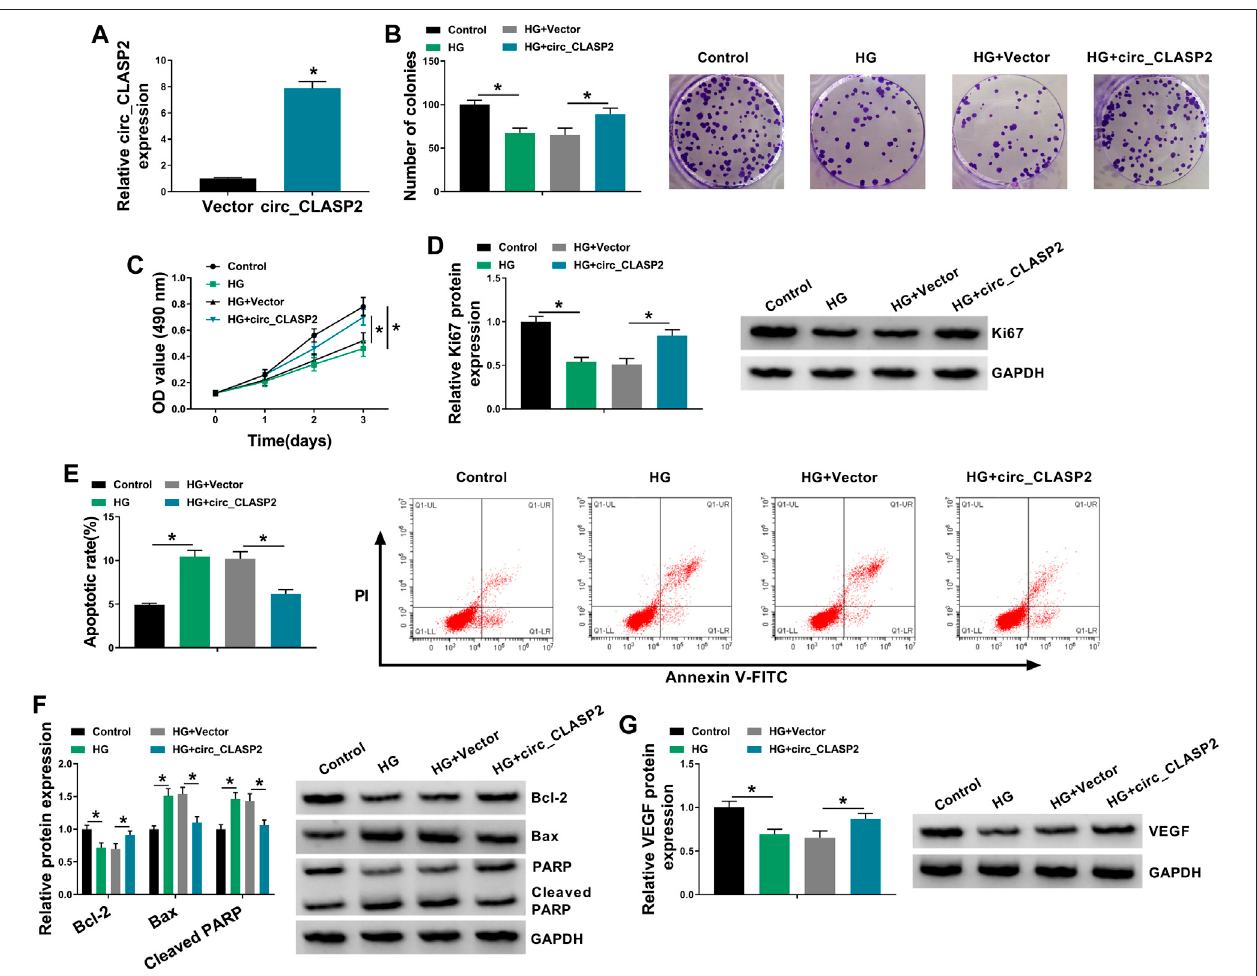
FIGURE 2 | Circ_CLASP2 overexpression promoted proliferation and inhibited apoptosis in HUVECs under HG conditions. (A) Circ_CLASP2 expression was assessed by qRT-PCR in HUVECs transfected with Vector or circ_CLASP2. HUVECs were transfected with Vector or circ_CLASP2 and then treated with HG, followed bythemeasurementofcellcolonyformationusingacolonyformationassay (B) ,cellproliferationbyMTTassay (C) ,Ki67levelbyWestern blot (D) ,cellapoptosisby fl ow cytometry (E) , Bcl-2, Bax and Cleaved PARP levels (F), and VEGF expression (G) by Western blot. Vector: negative control vector, circ_CLASP2: circ_CLASP2 overexpression vector. n (cid:2) 3 independent biological replicates; data were presented as mean ± SD; * p < 0.05 by a two-tailed Student ’ s t -test or ANOVA followed by Tukey – Kramer post hoc test.